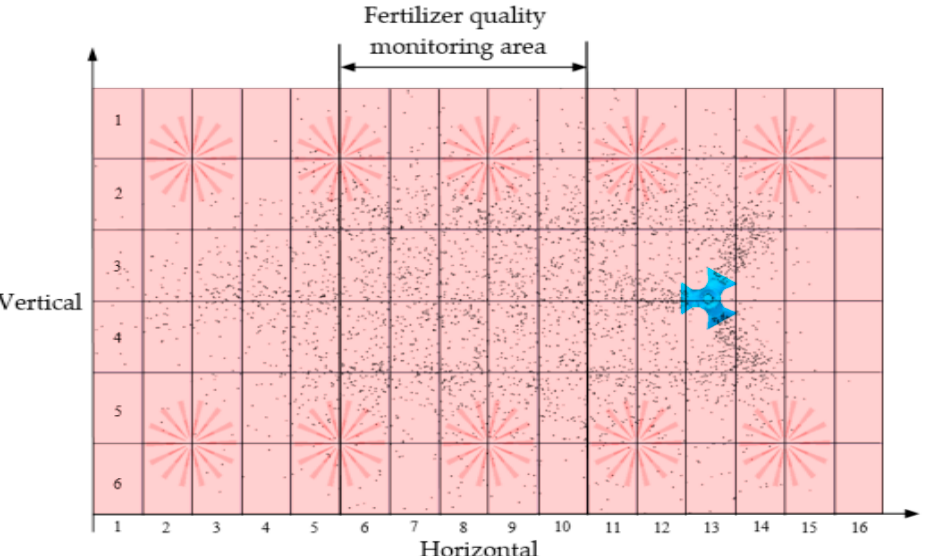
Figure 8. Schematic diagram of fertilizer monitoring area.